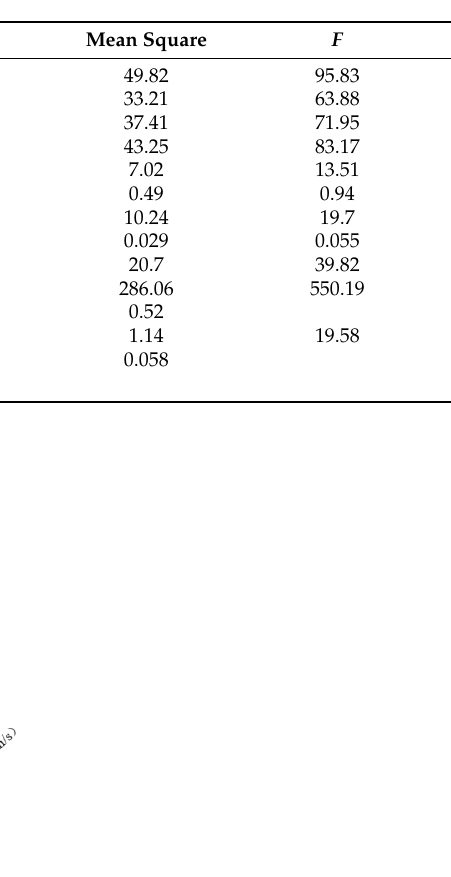
Figure 21. Interaction between wind velocity of blowers and drum rotational speed.